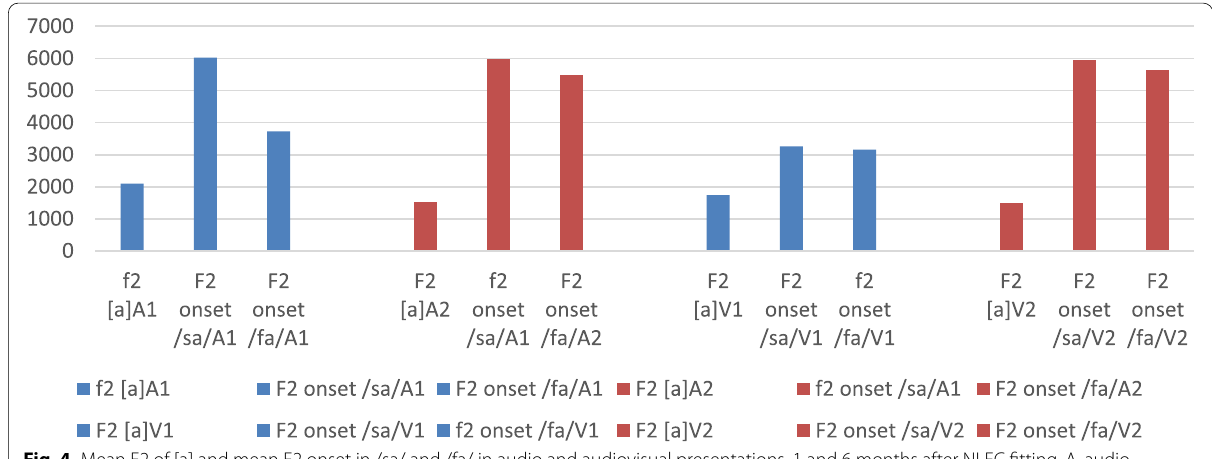
Fig. 4 Mean F2 of [a] and mean F2 onset in /sa/ and /fa/ in audio and audiovisual presentations, 1 and 6 months after NLFC fitting. A, audio presentation. V, audiovisual presentation. 1, first evaluation 1 month after NLFC filling (blue). 2, second evaluation 6 months after NLFC fitting (red)